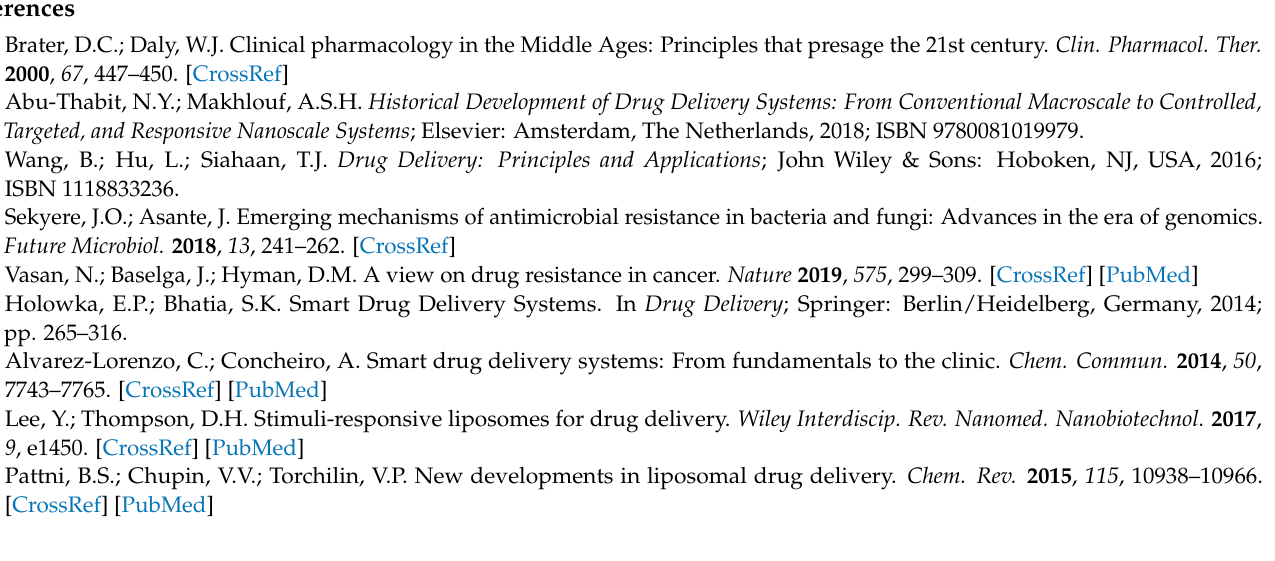
vices, Figure S1: Honey dipper, Figure S2: dimensions of the devices, Figure S3: SEM image of an as printed device (10,000 X), Figure S4: Section of a metallized device (optical microscope), Figure in Figure S5, Figure S7: Hydrogel loading procedure, Figure S8: Sample holder, Figure S9: VSM of an uncoated device, Supplementary Video S1, Supplementary Video S2, Supplementary Video S3, Supplementary Video